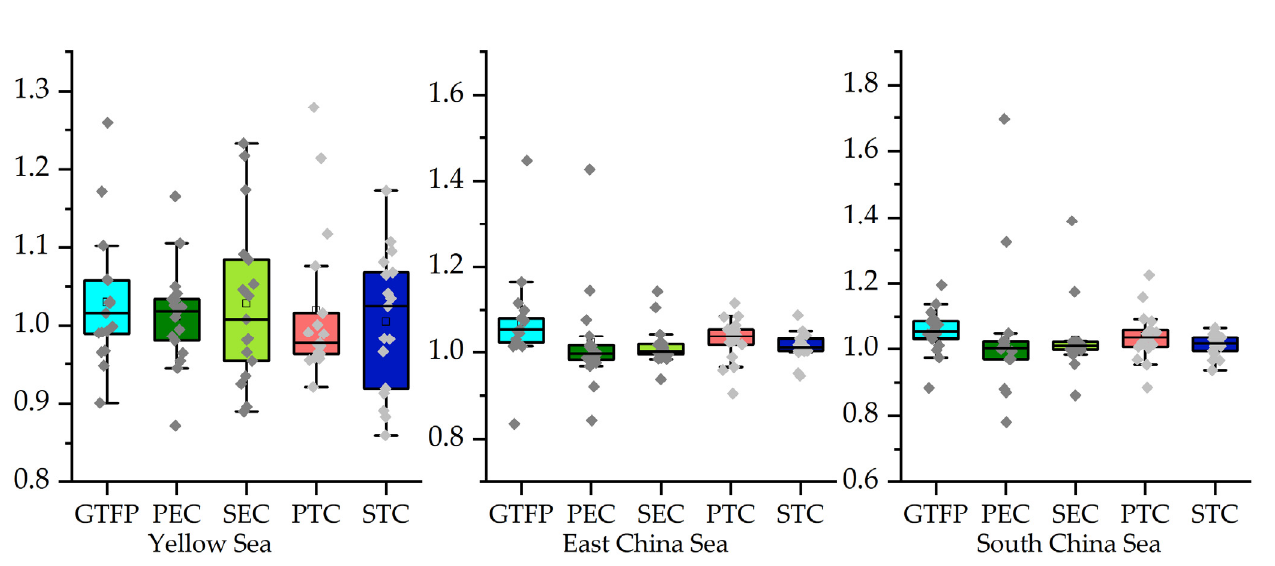
Figure 8. MGTFP index decomposition by regional division. Table 4 and Figure 9 report green total factor productivity and Zofio index decom-